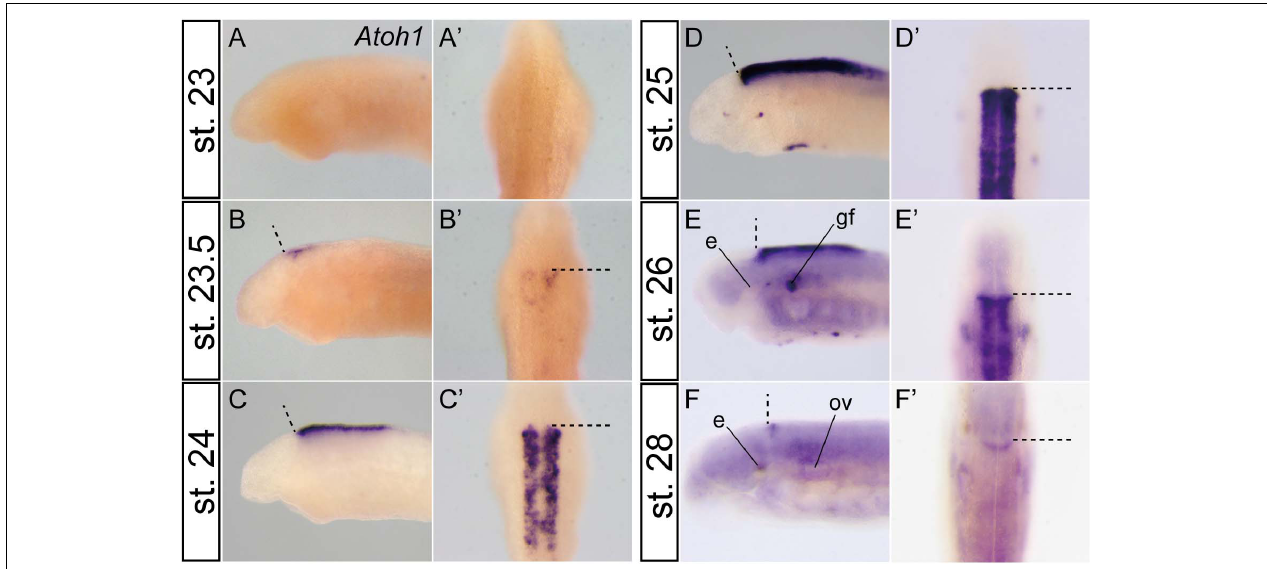
FIGURE 2 | Temporal Atoh1 expression pattern in the lamprey hindbrain. Lateral (A–F) and dorsal views (A’–F’) . Dashed lines indicate the MHB. Atoh1 expression starts at stage 23.5 in the rostral half of the rhombic lip (B) and subsequently expands throughout the rhombic lip during stages 24–26 (C–E) . After stage 27 (not shown), the expression is restricted only to the rostral border of the rhombomere 1 (F) . Note that the apparent asymmetrical staining in (B) does not reflect the actual difference in expression, but is caused by the staining process. e, eye; gf, complex of facial/lateral line ganglion; ov, otic